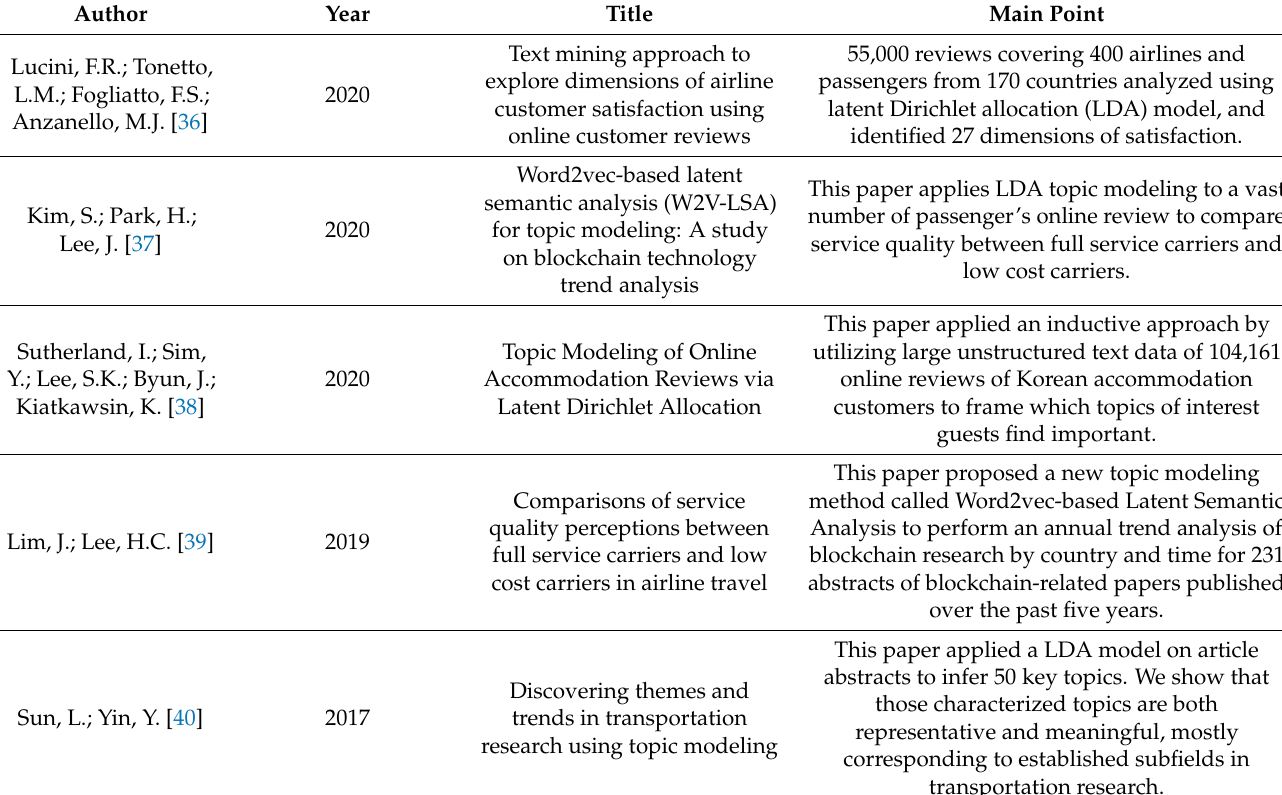
Table 1. Recent studies using topic modeling